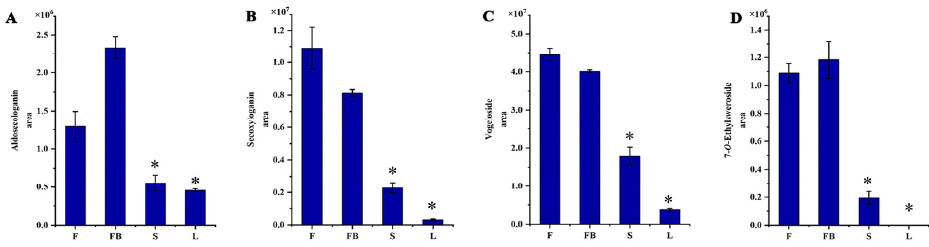
Figure 6. The content of iridoids in different tissues of LJT. ( A ) Aldosecologanin. ( B ) Secologanin, ( C ) Vogeloside. ( D ) 7- O -ethylsweroside. * means that significant difference was found between FB/S and FB/L.